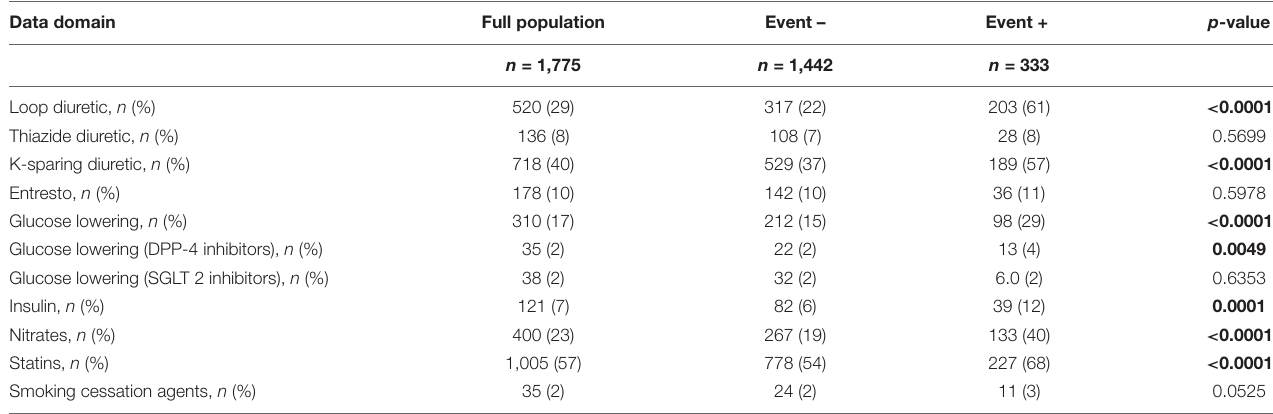
Frontiers in Cardiovascular Medicine |